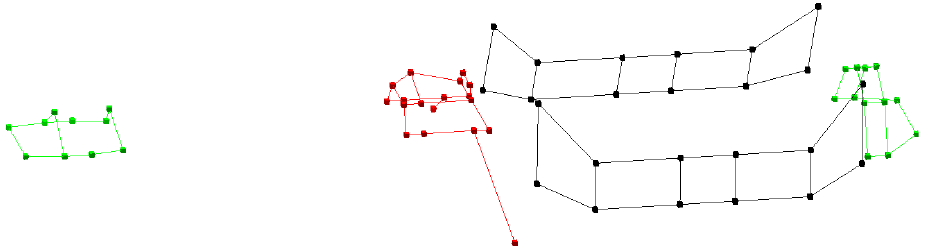
Figure 2. Measurement grid for OMA in standard operational conditions. Green and red components are related to bearing pedestals, while black components are related to the generator casing. Points encircled with green eclipse are related to the bearing with excessive vibration levels. The leftmost green component is related to one of the bearings. The center red component is related to two bearings in one bearing pedestal. Points encircled in green eclipse are related to the bearing with excessive vibration levels. Black components are related to the generator casing. The rightmost green components are related to the last bearing.